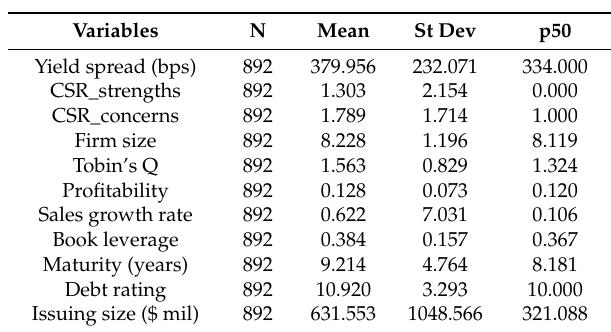
Table 1. Summary statistics.